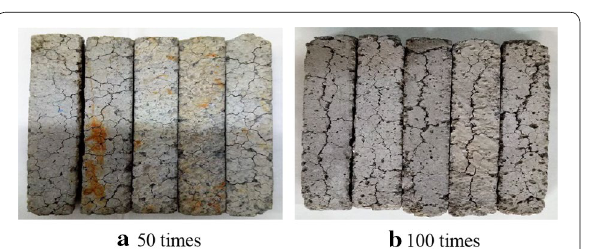
Fig. 2 Appearance changes after dry–wet cycle erosion.